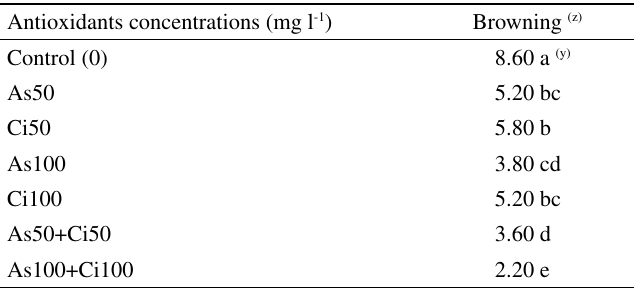
Table 2 - Effect of different antioxidants on browning rate of Dracaena sanderiana Sander ex Mast.